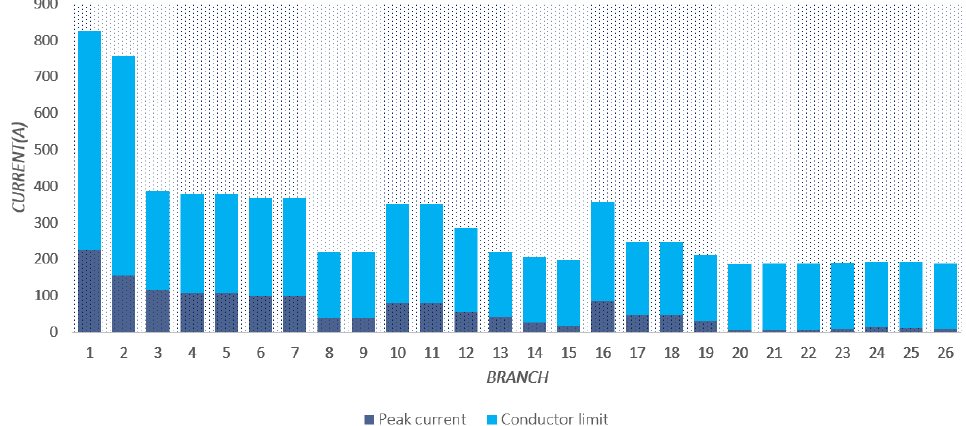
Figure 10. Behavior of the current in the branches for the IEEE system of 27 buses (unbalanced).